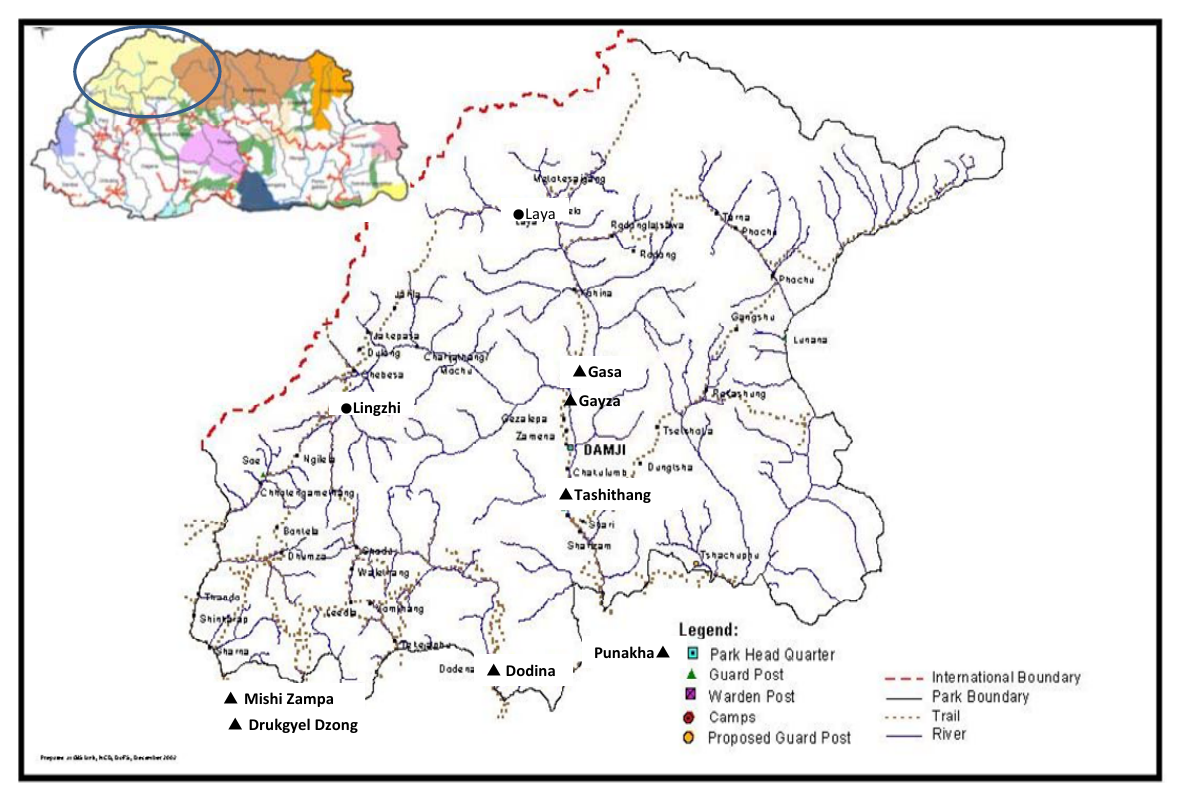
Figure 8. Map of Jigme Dorji National Park [2].